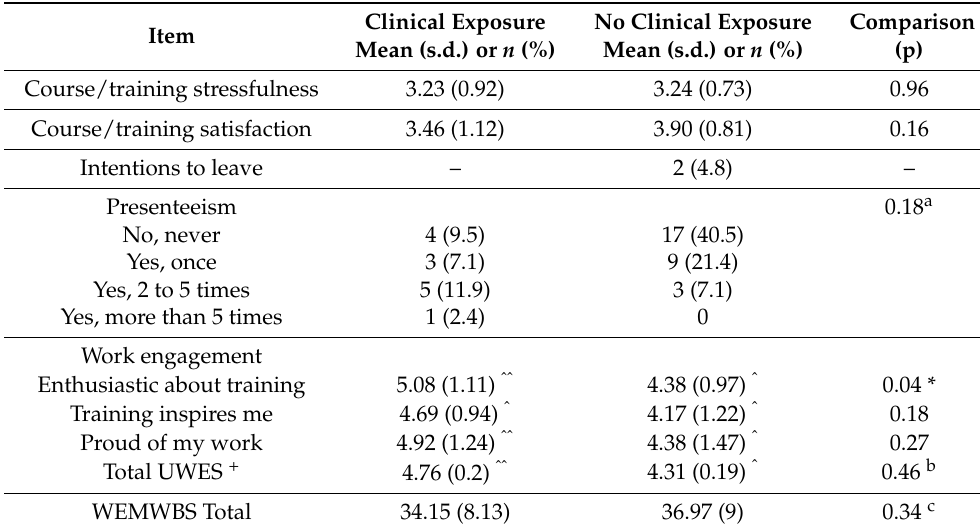
Table 2. Wellbeing and perceptions of training by clinical exposure ( n = 42).